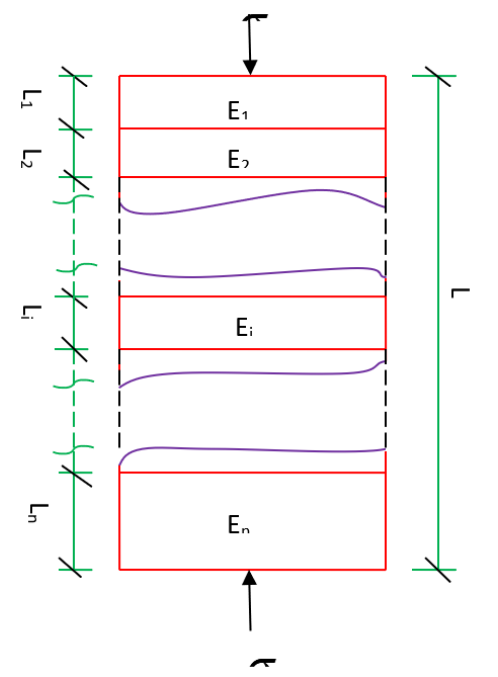
Fig. 1 Action diagram of layered composite rock under transverse stress σ .